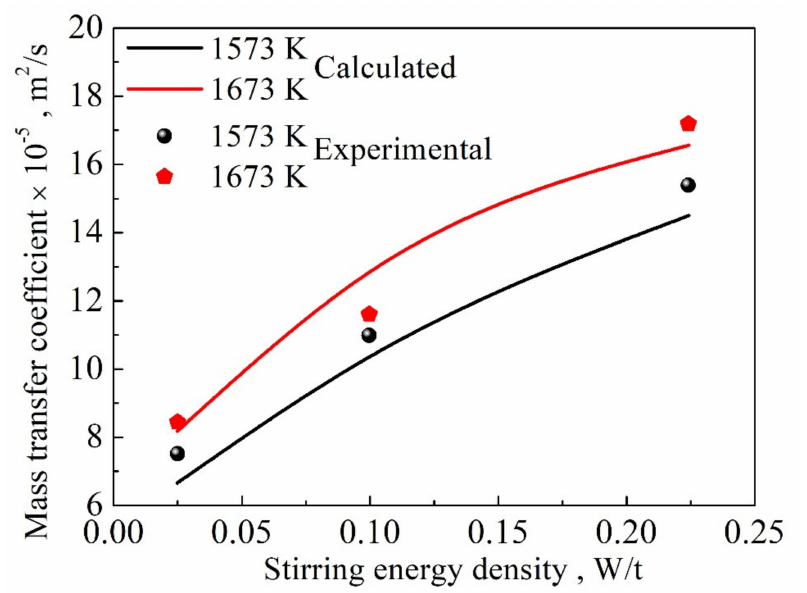
Figure 5. Validation of the explicit function under forced convection